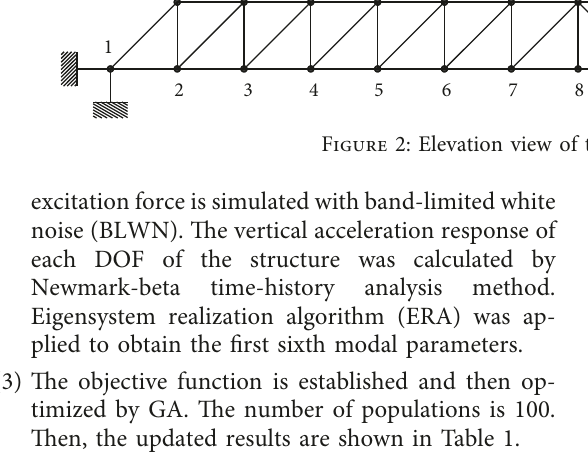
0 , 1 and X 2 has a normal distribution N [ ]